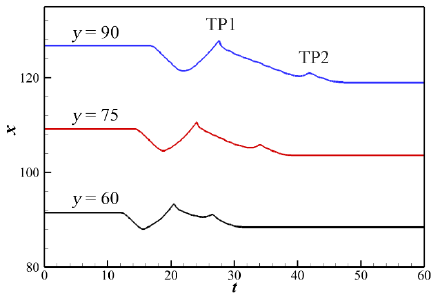
Figure 8. Shock-front positions along the lines y = 60, 75, and 90 when M 0 decreases from 6.0 to